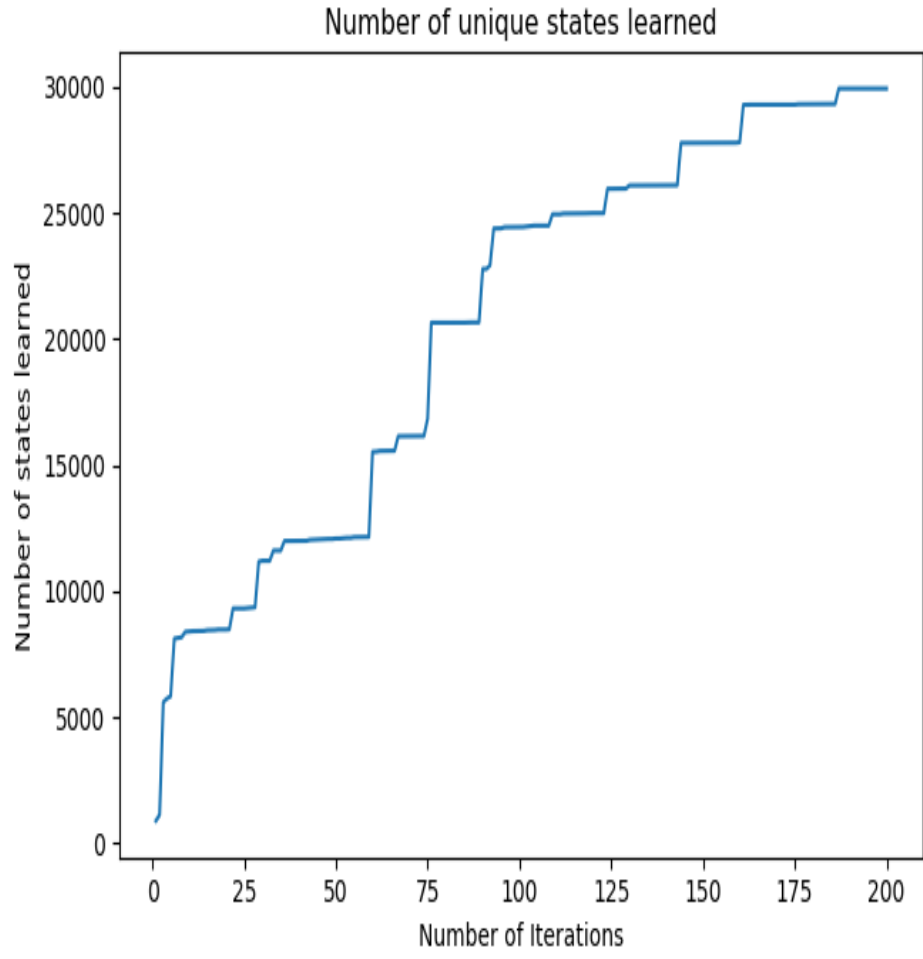
Figure 11. Exact Q-learning agent: Number of distinct states learnt vs. number of iterations. Model converges around 200 iterations.